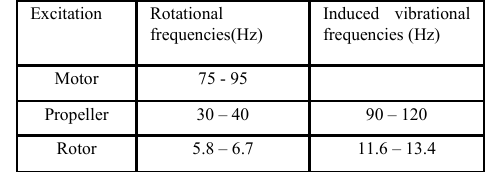
Figure 1. Three views of MTOsport (MTOsport, 2011) Apart from the wind-induced oscillations, the vibrations induced by the motor, the propeller and by the main rotor are prominent, see Table 1 for the typical frequencies.